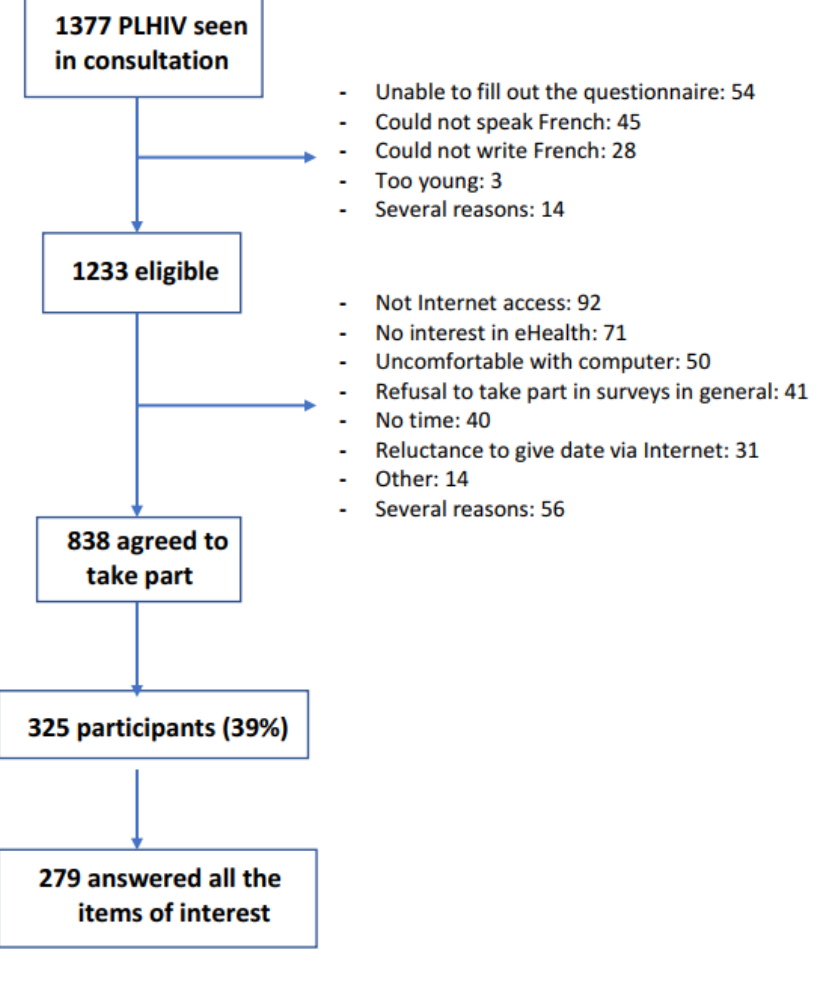
Figure 1. Flowchart of the 279 people living with HIV (PLHIV) who answered all items of